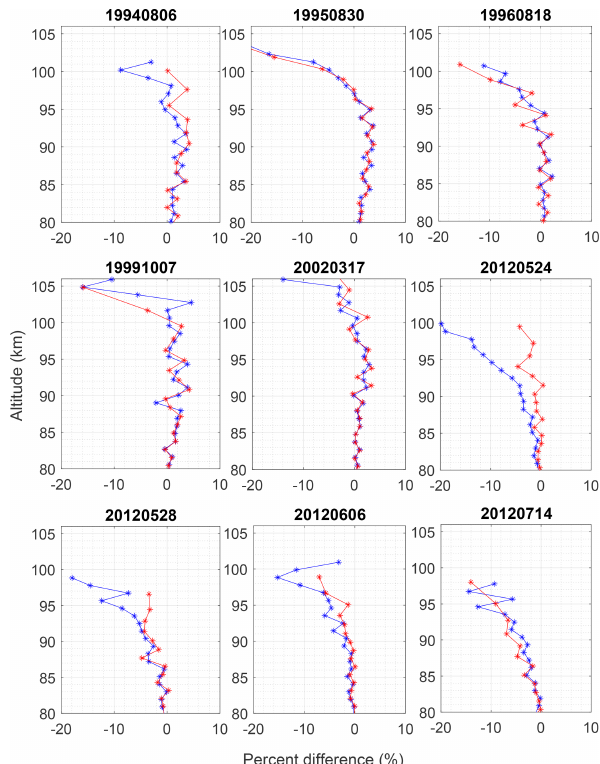
Figure 18. The percent difference between the fine-grid retrieval with the HC method (blue line) and coarse-grid retrieval (a priori removed) with the HC method (red line). Below 80km the retrievals are identical, as the coarse and fine grid are identical.